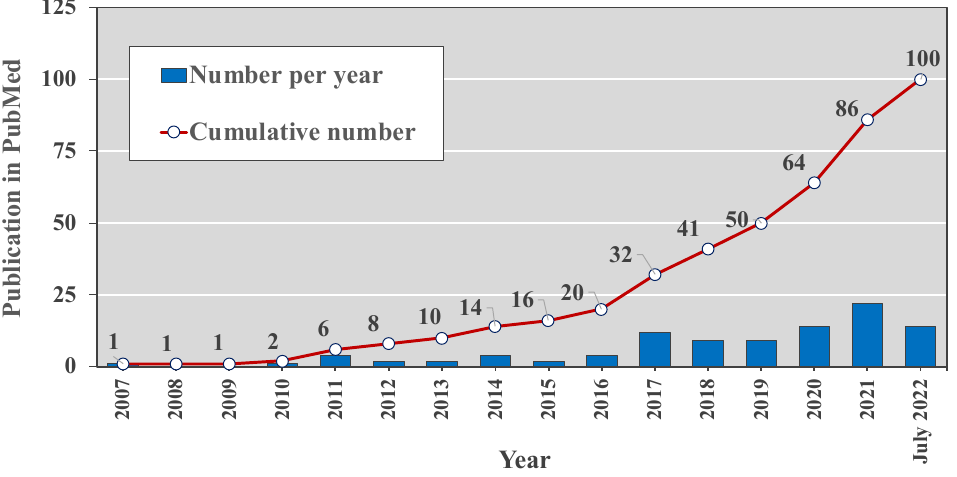
Figure 1. The number of peer-reviewed publications in the PubMed database during 2007–2022 with search terms (“human milk” OR “breastmilk”) AND (“exosomes” OR “extracellular vesicle ” ).